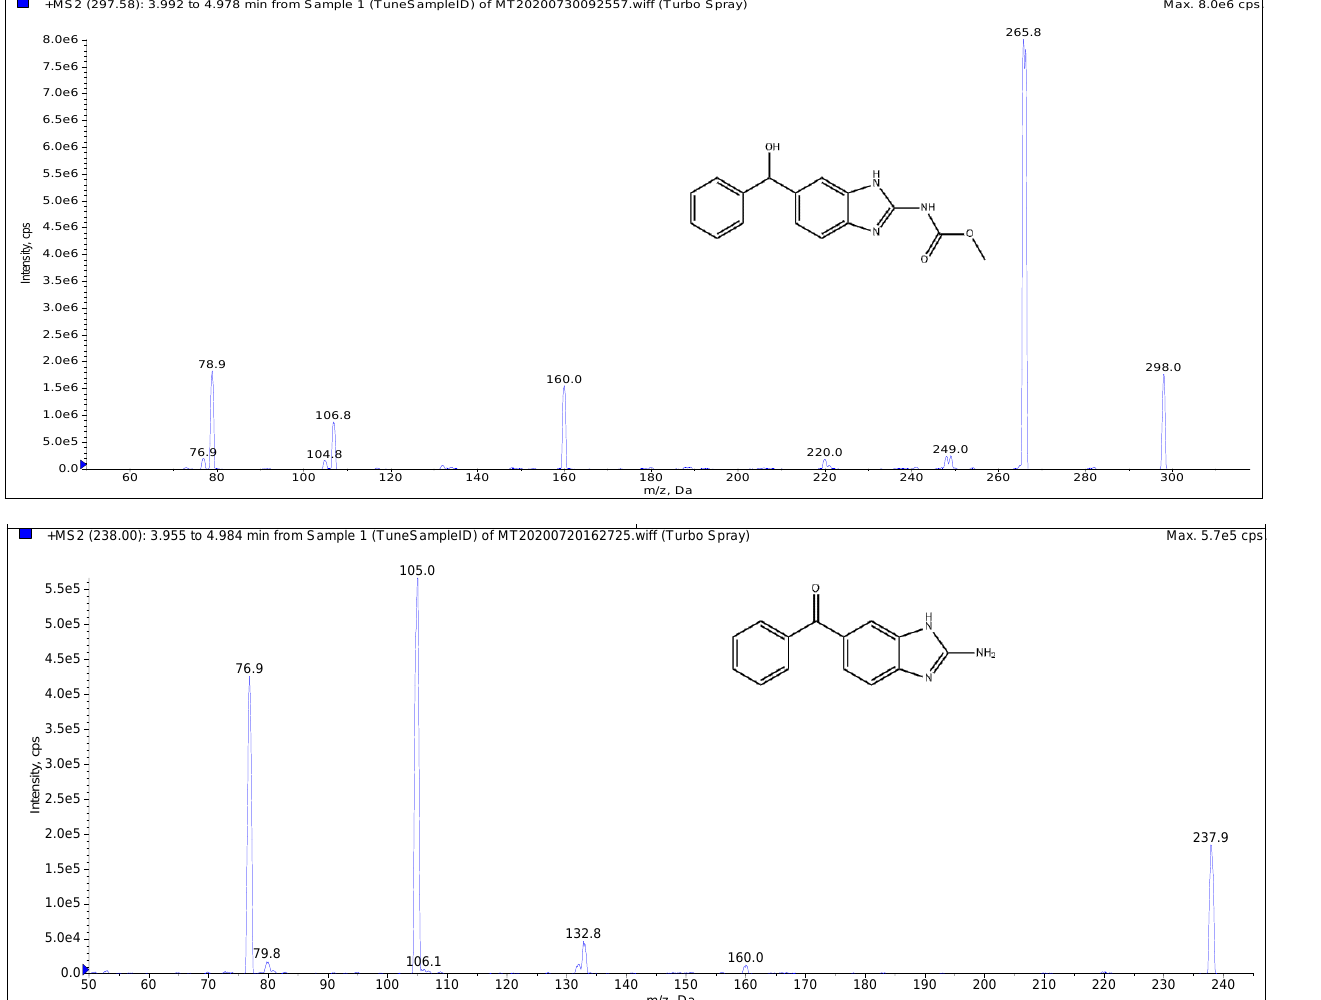
Figure 2. Chemical structures and MS/MS spectra. (( a – d ) correspond to LMS, MBZ, HMBZ, and AMBZ, Figure 2 . Chemical structures and MS/MS spectra. (( a ), ( b ), ( c ), and ( d ) correspond to LMS, MBZ, HMBZ, and AMBZ, respectively)